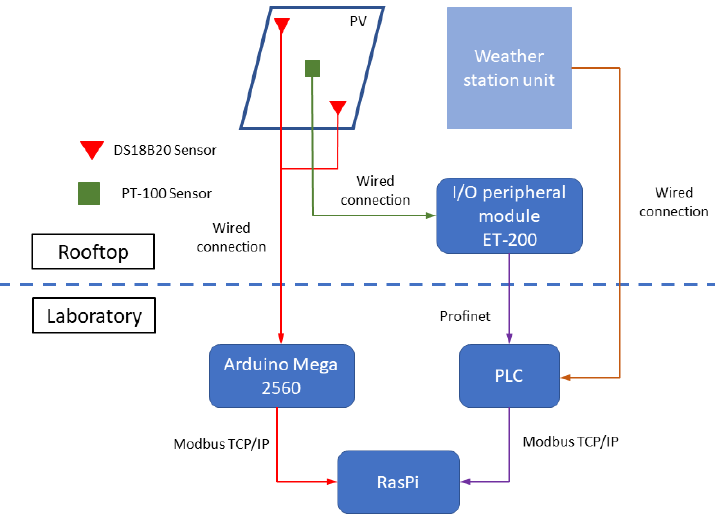
Figure 1. Installation overview.